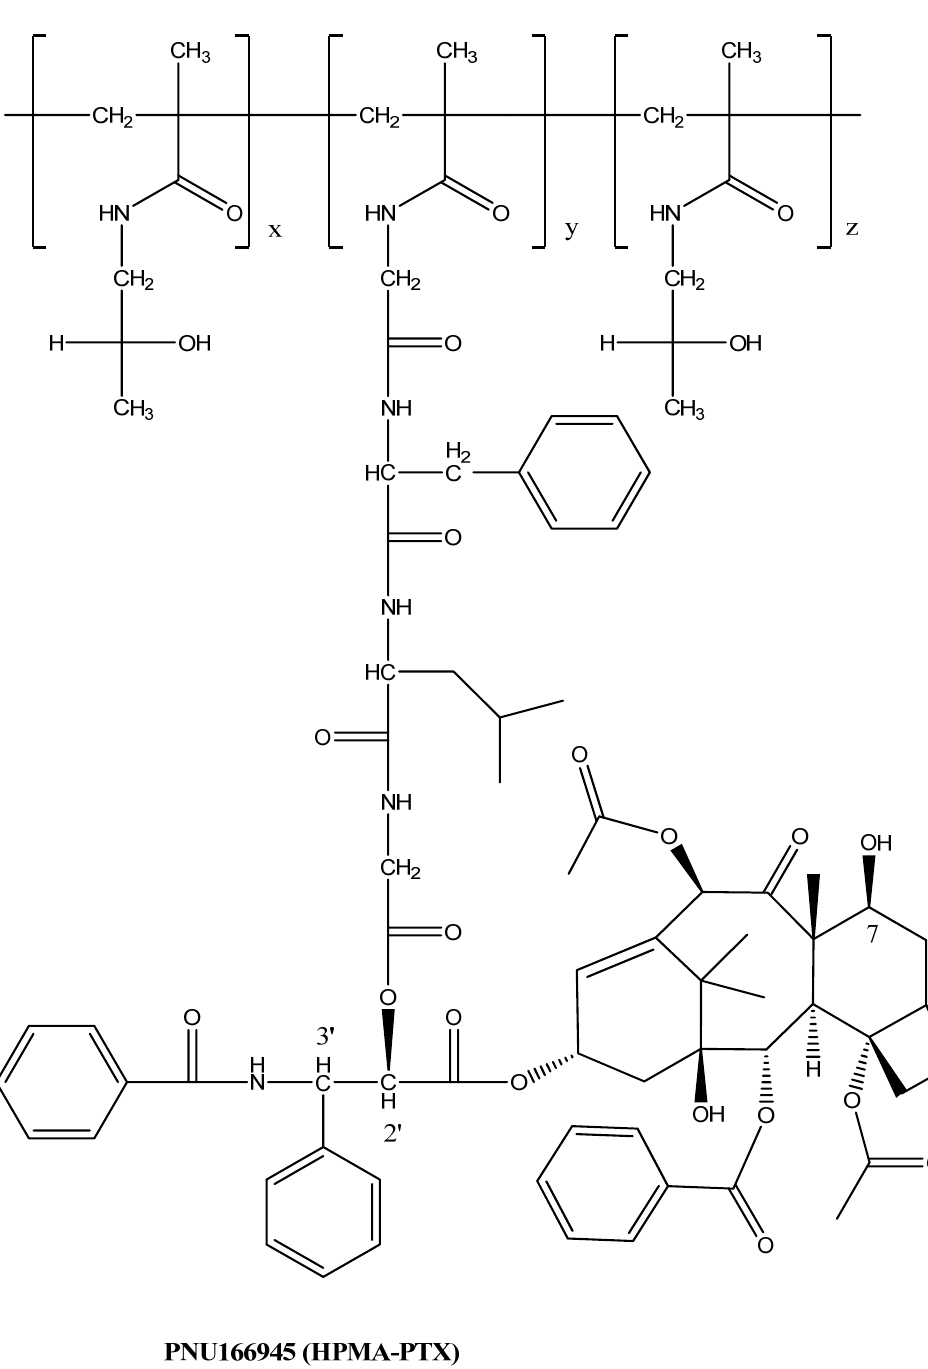
Figure 2. Structure of